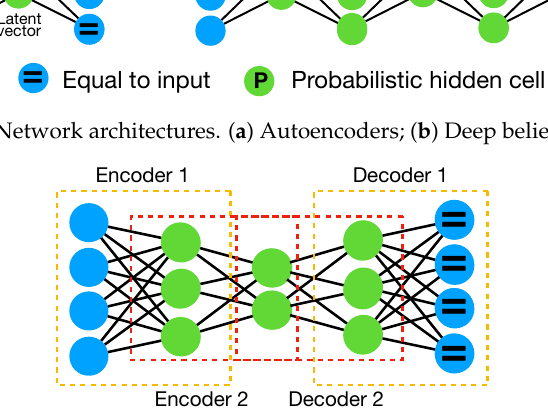
Figure A3. Network architecture of a Stacked